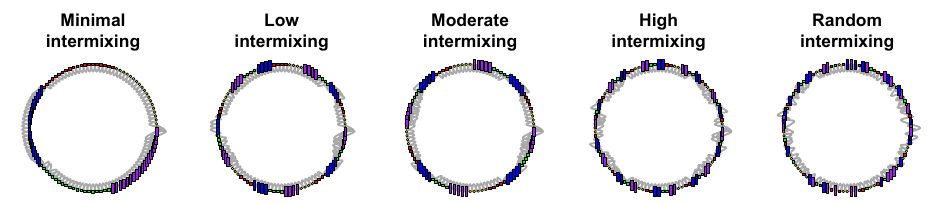
Fig. 3 Intermixing of diverse knowledge. Intermixing distributions of the fi ve initial states of knowledge in networks for the diversity of knowledge simulations